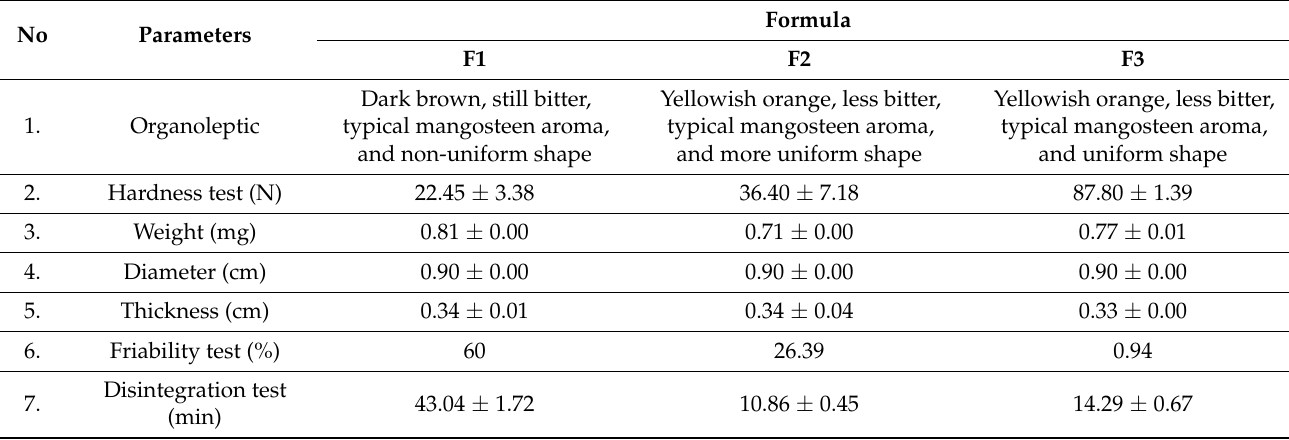
Table 7. Tablet properties of the optimized